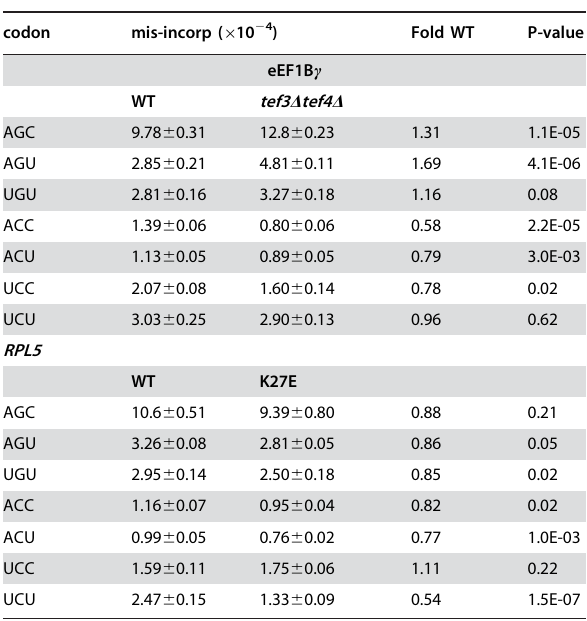
Table 3. Survey of isogenic wild-type and mutant pairs of strains with seven different codons at codon 218 of firefly